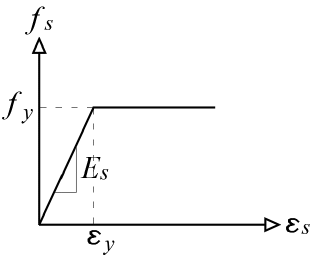
Figure 4. Concrete tensile softening.